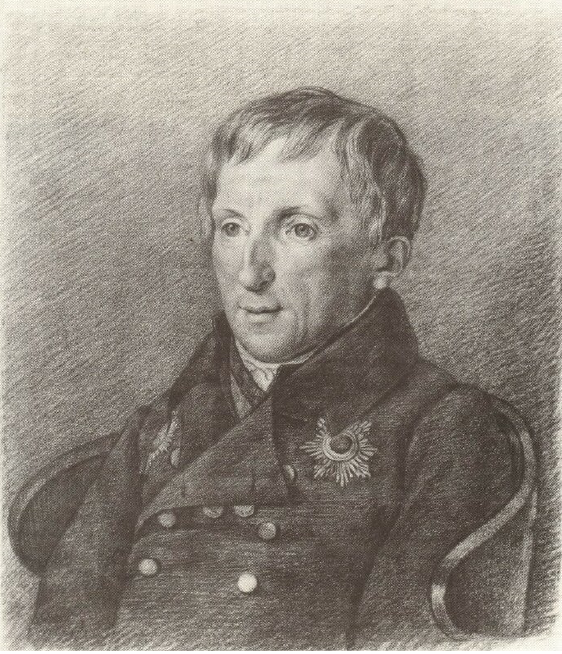
Figure 19. Alexander Varnek. A Portrait of Aleksei Olenin (sketch), 1818. All-Russian Pushkin Museum, Saint Petersburg and Tsarskoe Selo (Pushkin).